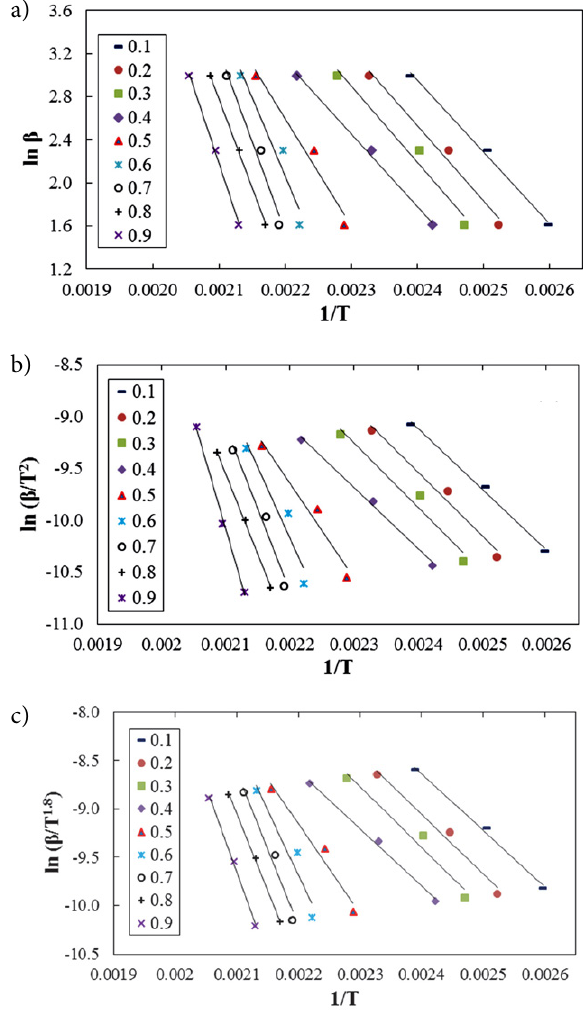
Figure 8. Plots of (a) FWO, (b) KAS, and (c) Starink methods for the first decomposition stage of the CTT crystals obtained in pure